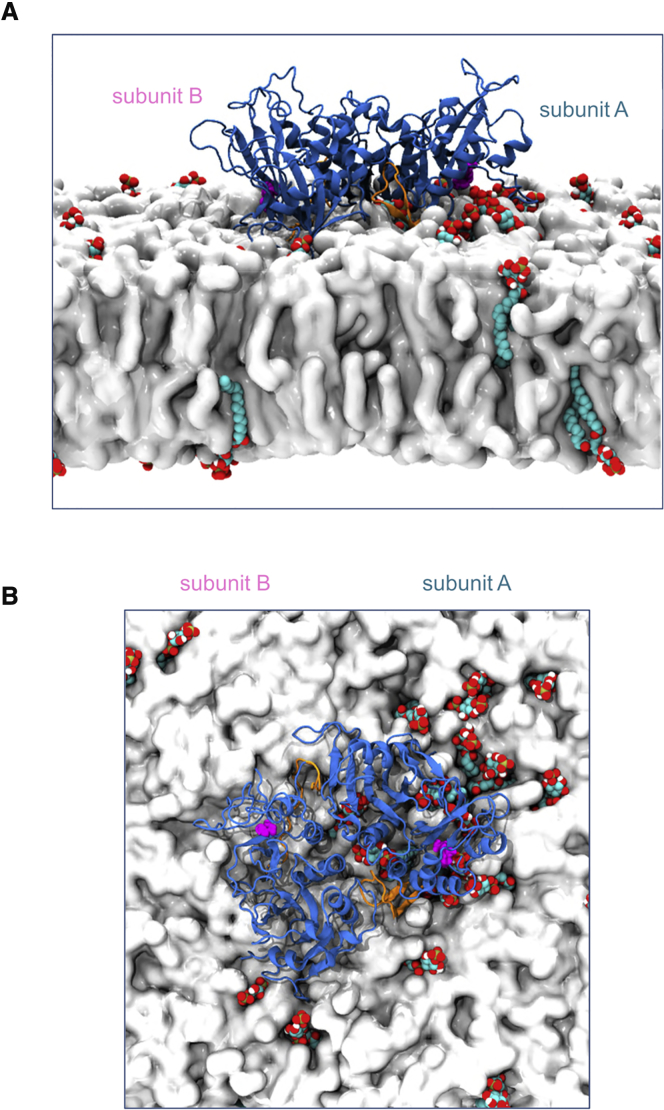
Final Configuration of the Membrane-Bound Dimer(A) Snapshot of the dimer bound to the membrane after 1 μs of atomistic simulation. The kinase is shown in blue with the catalytic motif highlighted in magenta and the activation loops highlighted in orange. PI4P lipids are shown in red, white, and cyan and PC/PS lipids are shown in white for clarity. A number of PI4P molecules can be seen clustering around the bound monomer's catalytic site, whereas the unbound monomer remains close to the membrane but not bound to any PI4P molecules.(B) Snapshot of the bound dimer viewed from above. Multiple PIPs are seen clustered around the bound subunit A with no PI4P molecules in contact with subunit B.